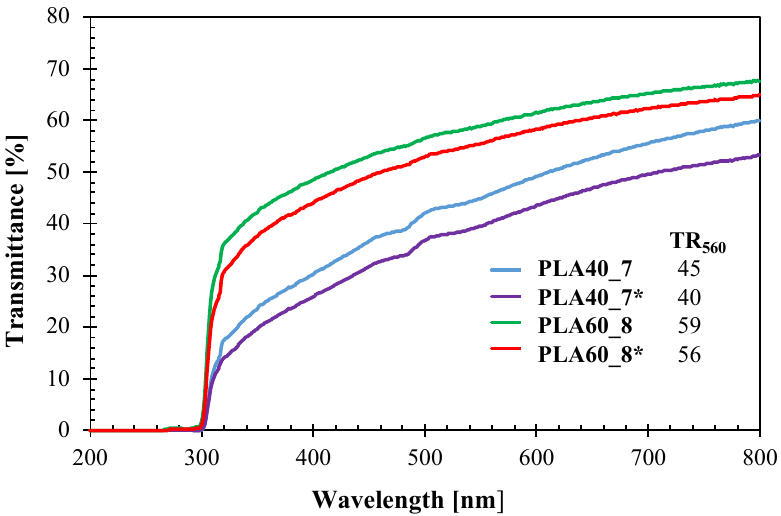
Figure 4. UV–Vis transmittance spectra and percent transparency values at 560 nm (TR 560 ) of the films (samples named with the asterisk were produced without cooling air).